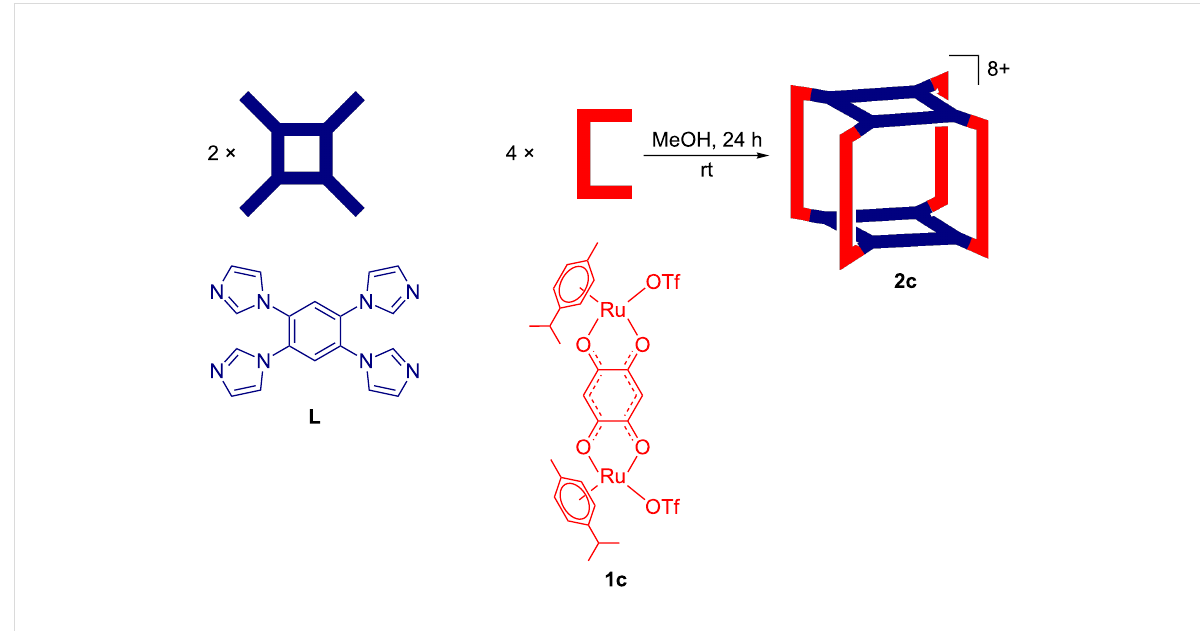
Scheme 3: Formation of an octanuclear macrocycle 2c upon reaction of Ru(II) 2 -based acceptors 1c with imidazole-based tetratopic donor L in methanol at room temperature.